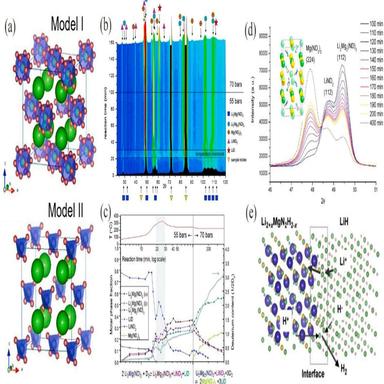
(a) Crystal structure models of Li2NH:Model I: Fm 3m symmetry for the hydrogen atoms at the 48 h site; Model II: F 4 3m symmetry for hydrogen atoms at the 16e site ; (b) In situ diffraction patterns LiNH2 and MgH2 during deuteration of at 55 and 70 bar with a reaction time of up to 160 min; (c) Evolution of molar phase fractions from 0 to 400 min (log scale is applied for clarity); (d) Time-resolved series of diffraction patterns at 498 K and 70 bar. Inside picture is the refined structure of